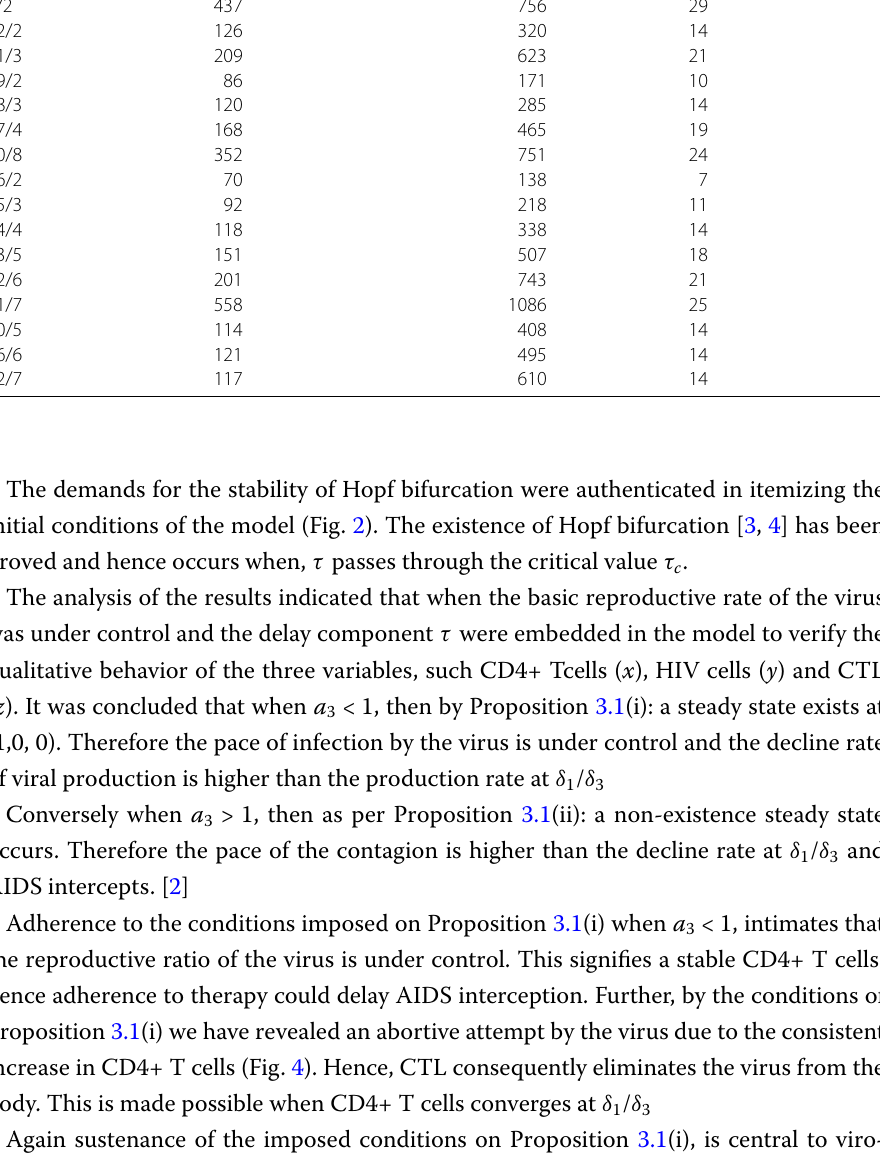
Table 1 Demonstration of treatment strategies, viral load level and corresponding cost Strategy on/off days Average Viral haul Virions/ml Peak Viral